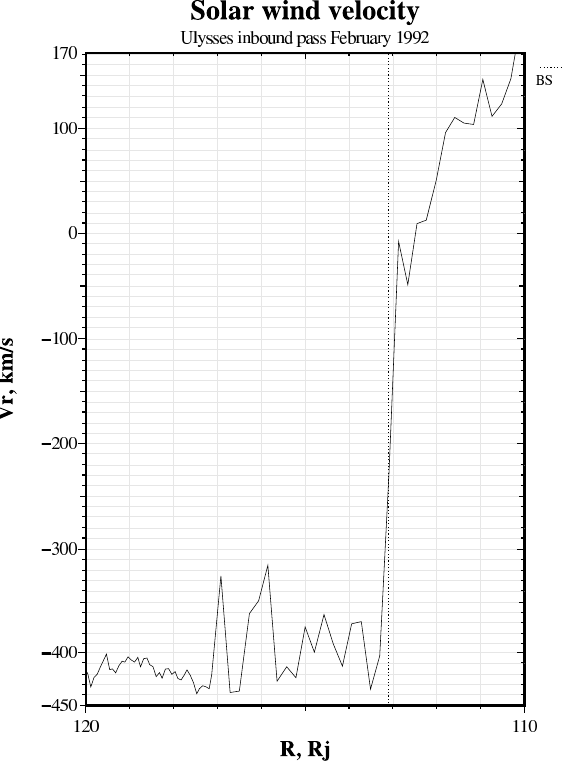
Fig. 9. Measured by SWOOPS plasma density in the course of the bow shock crossing by Ulysses during the first Jupiter flyby, February 1992. The bow shock position is marked by a dashed vertical line. Data (SWOOPS, PI J. L. Phillips LANL, USA) are received by using the COHOWEB system, NSSDC, NASA/GSFC, USA; ftp://nssdcftp.gsfc.nasa.gov/spacecraft data/ ulysses/plasma/swoops/jupiter.